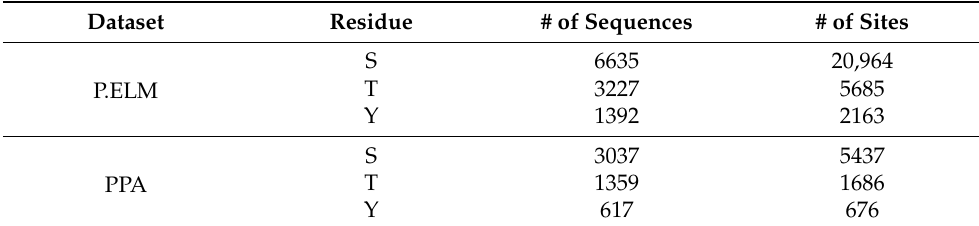
Table 4. The numbers of protein sequences and known phosphorylation sites used in this study in the P.ELM and PPA dataset. Dataset Residue # of Sequences # of